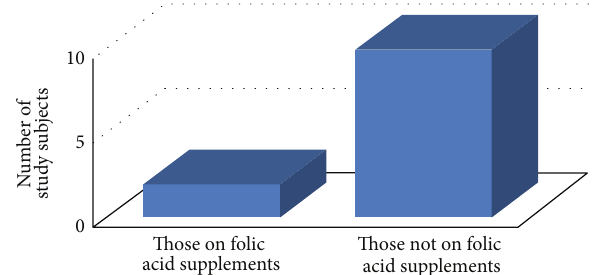
Figure 1: Number of study subjects having hyperhomocysteinemia ( > 15micromol/L) in the